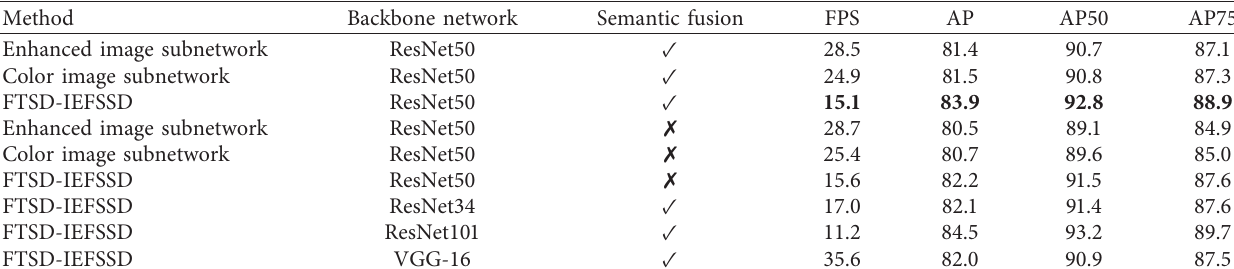
Table 6: Comparisons of different network structures in the FTSD-IEFSSD for